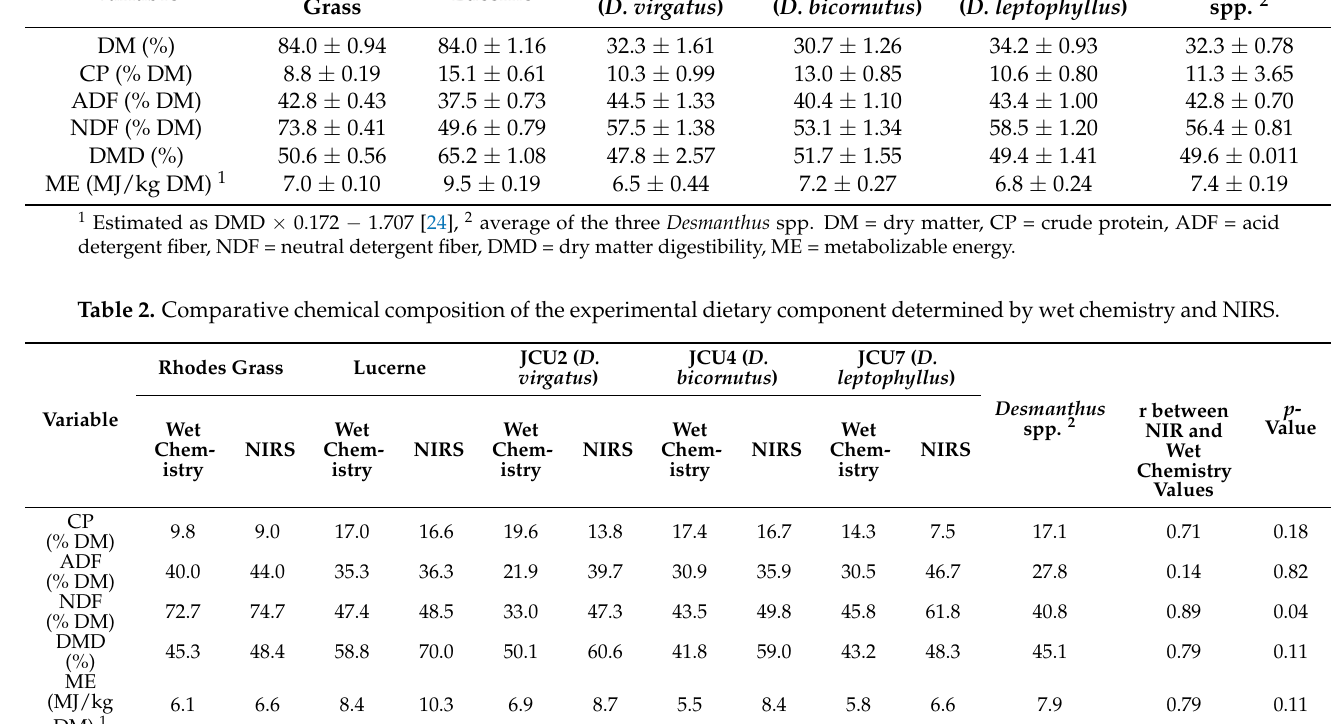
Table 1. Chemical compositions (mean ± s.e.) of dietary components predicted by near infrared reflectance spectroscopy. Variable